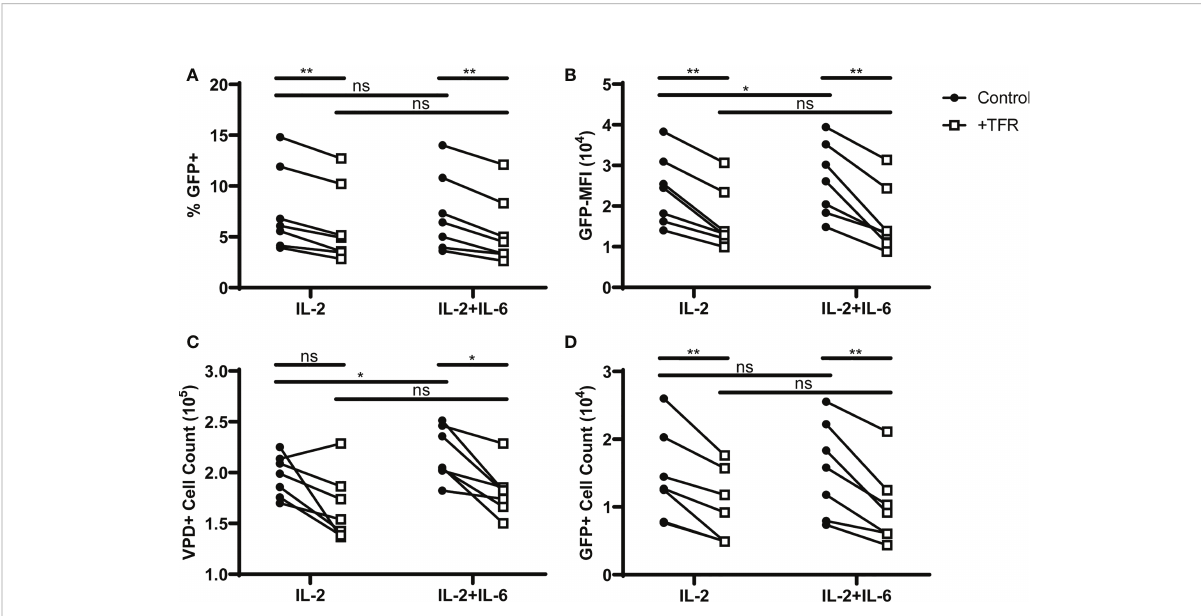
FIGURE 5 IL-6 does not block IL-2 mediated effects on TFH viability or HIV replication, or TFR-mediated inhibition of TFH viability or HIV replication. TFH were spinoculated with CXCR4-tropic HIV, labeled with VPD, and cultured at a ratio of 1:1 with unlabeled, uninfected TFH (Control) or TFR in the presence of 5 m M saquinavir and 10 IU/ml IL-2 or 10 IU/ml IL-2 and 5 ng/ml IL-6 for 5 days (n=7). (A) Percent GFP + expression and (B) GFP- MFI in GFP + VPD + TFH were determined in cocultures with IL-2 or IL-2 and IL-6 using the gating strategy in Figure 1. (C) Total VPD + TFH and (D) GFP + VPD + TFH cell counts were determined in cocultures supplemented with IL-2 or IL-2 and IL-6. All graphs represent data collected from the same six cocultures. Statistical analyses were performed using 2-way ANOVA and Sidak ’ s multiple comparisons tests (Graphpad Prism v8) and signi fi cance indicated: ns not signi fi cant; *p<0.05;